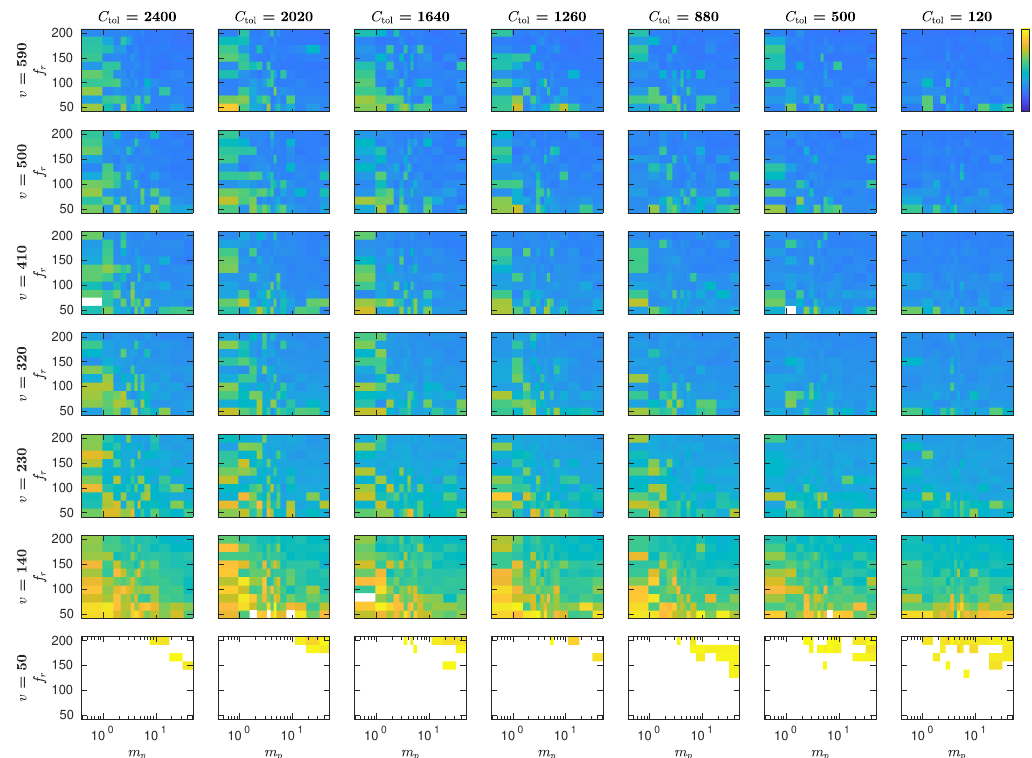
Figure A2. First male arrival time to the female, normalized by the total simulation time t sim = 20 s using MothPy [75] as described in Appendix C. White regions correspond to no male moths reaching the female within t sim , velocities v are measured in cm/s; female pheromone amounts m p are measured in pg; pheromone puff release rates f r are measured is s − 1 ; and pheromone detection thresholds C tol are measured in pg/cm 2